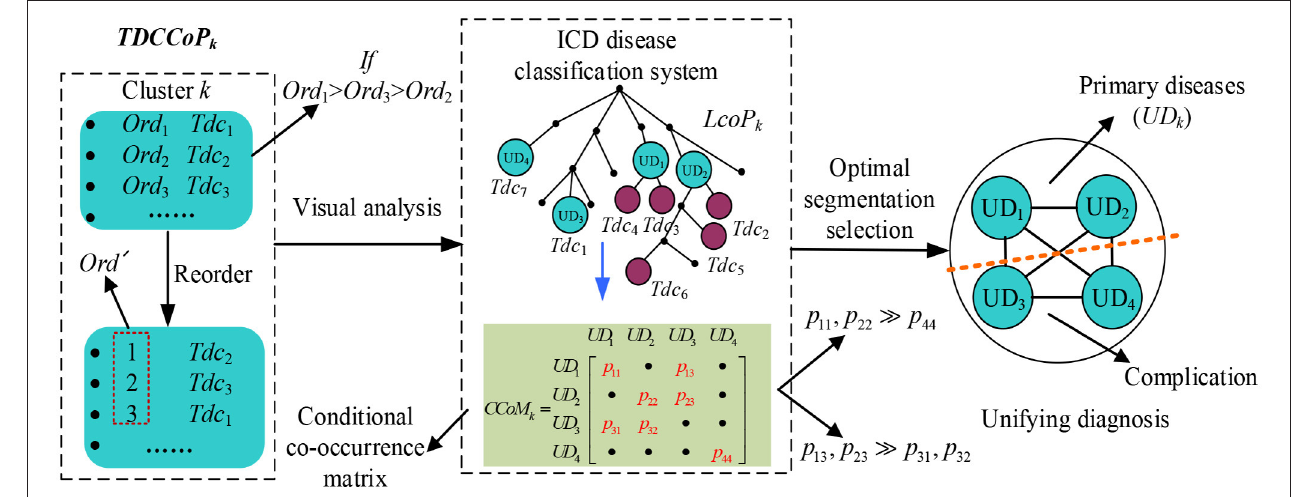
FIGURE 5 | Proposed UD identification